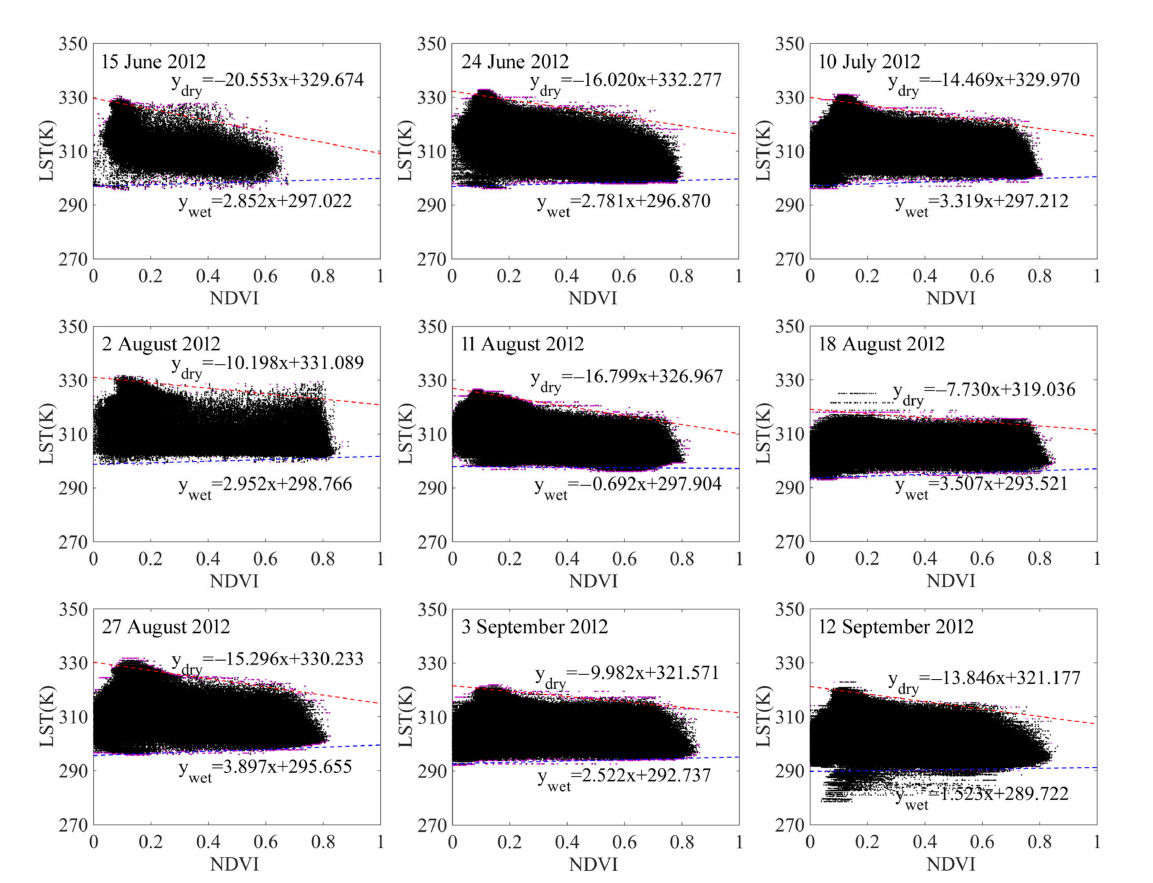
Figure 3. NDVI/LST triangle or trapezoid scatter plots derived by ASTER LST and NDVI at the middle reach of